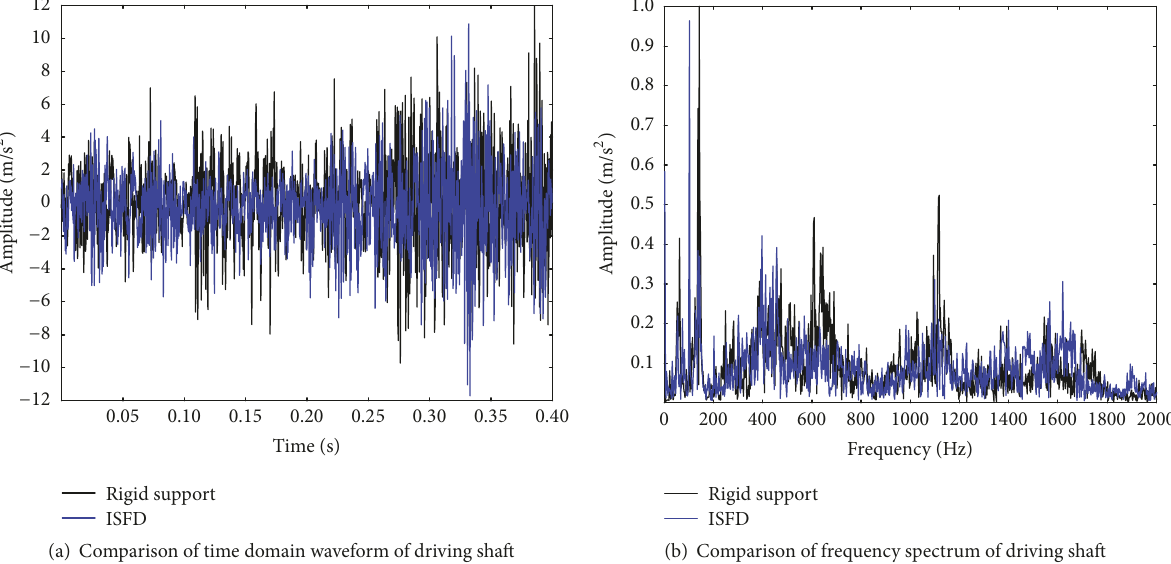
Figure 9: Comparison of vibration of driving shaft measuring